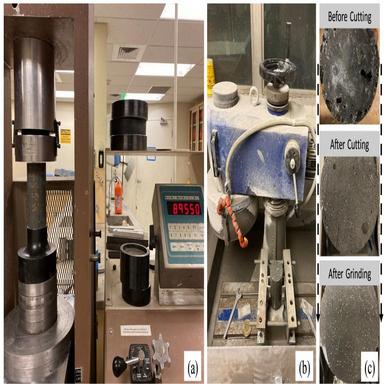
Compression testing of NP-UHPC cylinders: (a) test setup; (b) grinding machine for cylinder preparation; and (c) views of typical NP-UHPC cylinder through preparation sequence.